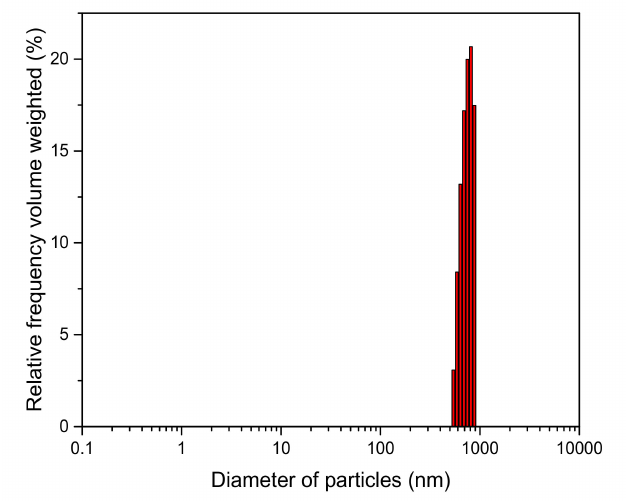
Figure 4. Distribution of ZrO 2 -TiO 2